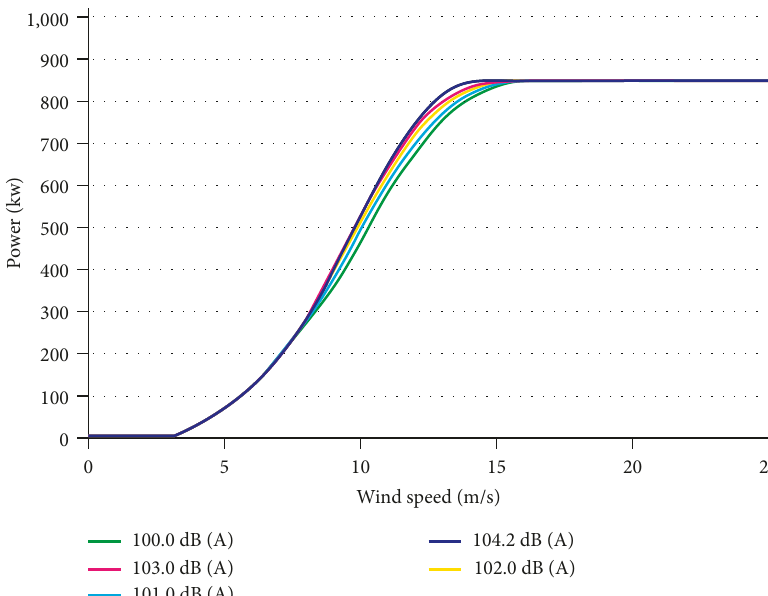
Figure 1: The power curves of V52-850 kW turbine at different sound